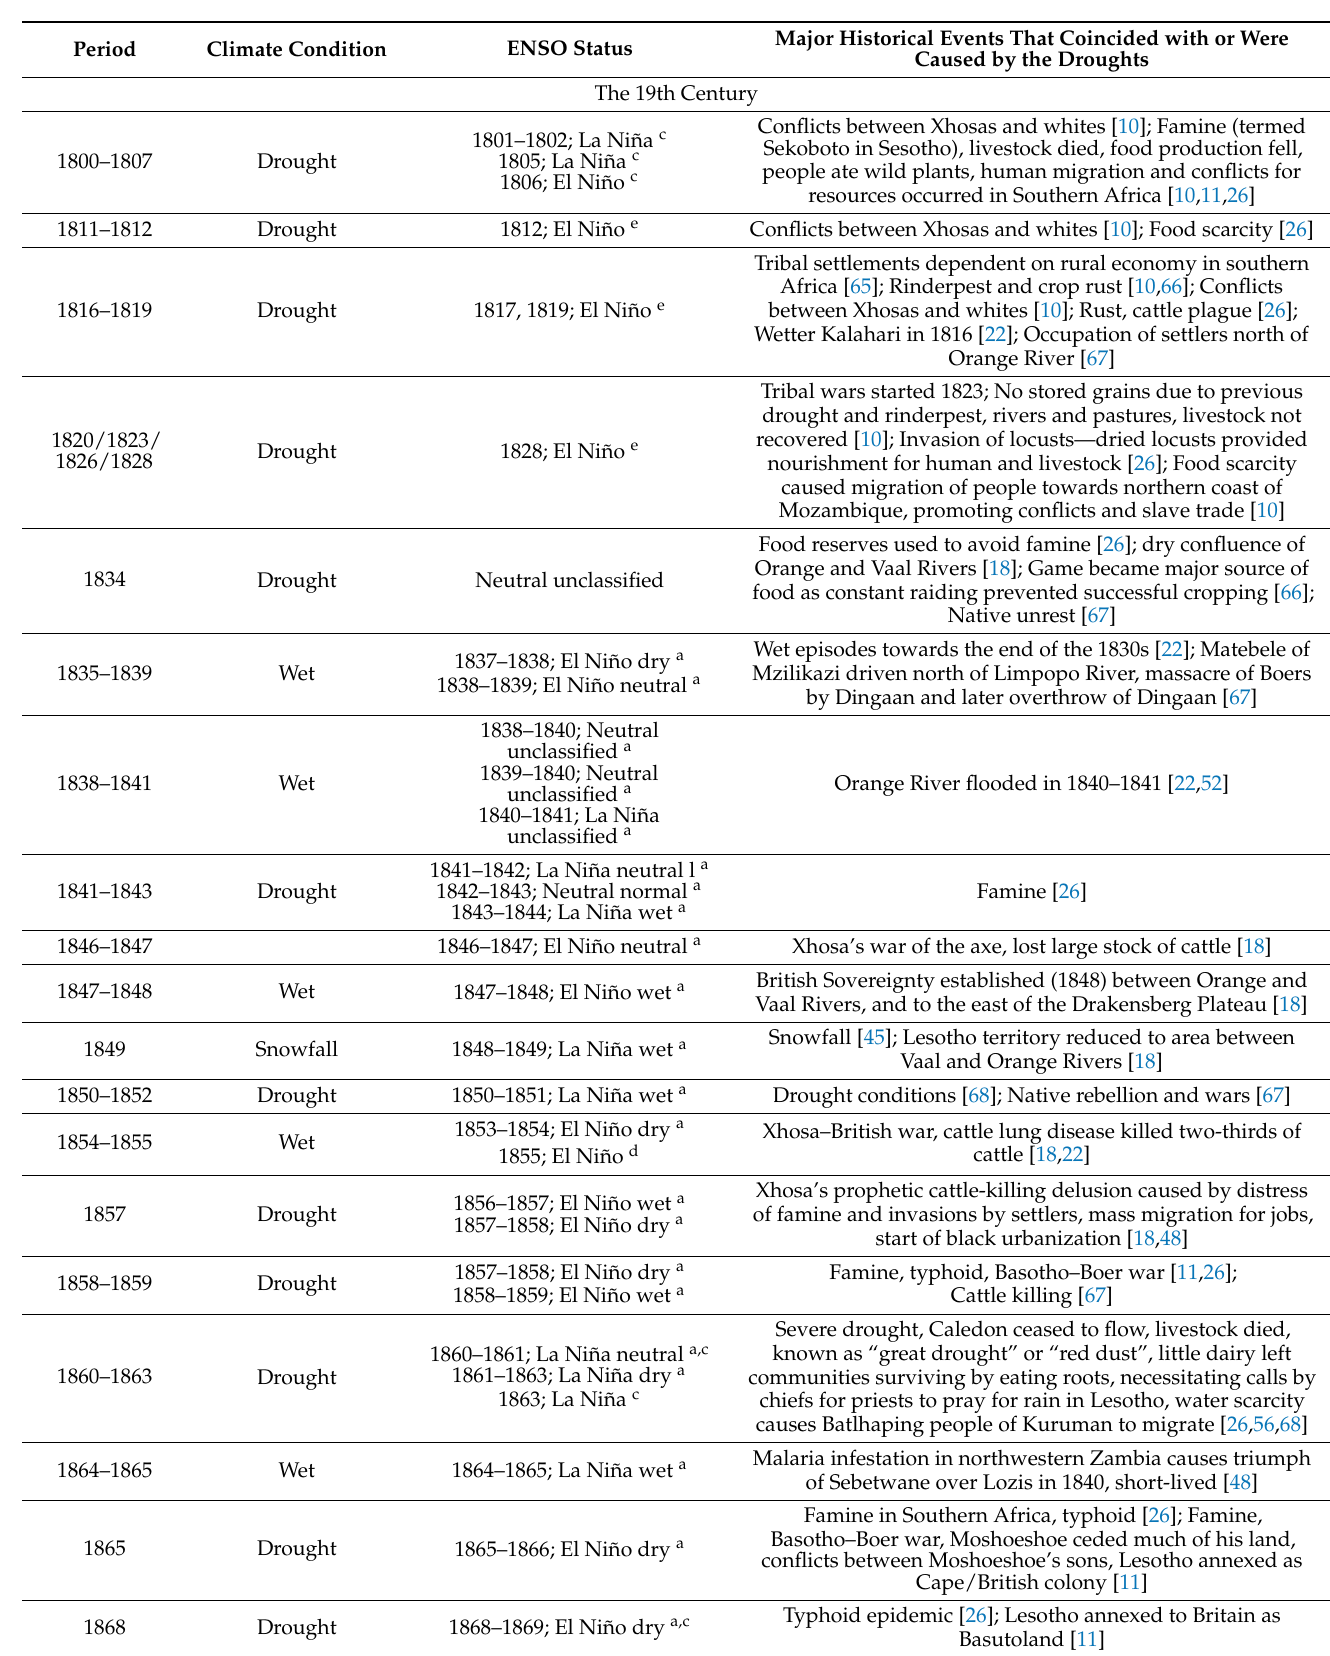
Table 1. A compilation of historical incidences potentially caused by climate variability in Southern